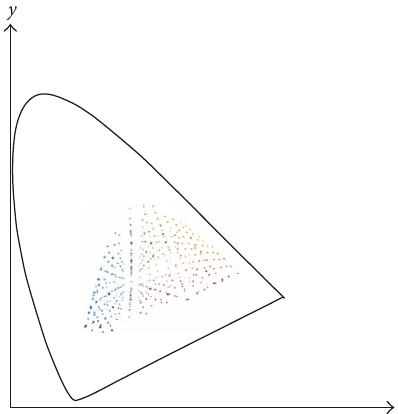
Figure 2: The 424 OSA-UCS samples represented in the xy